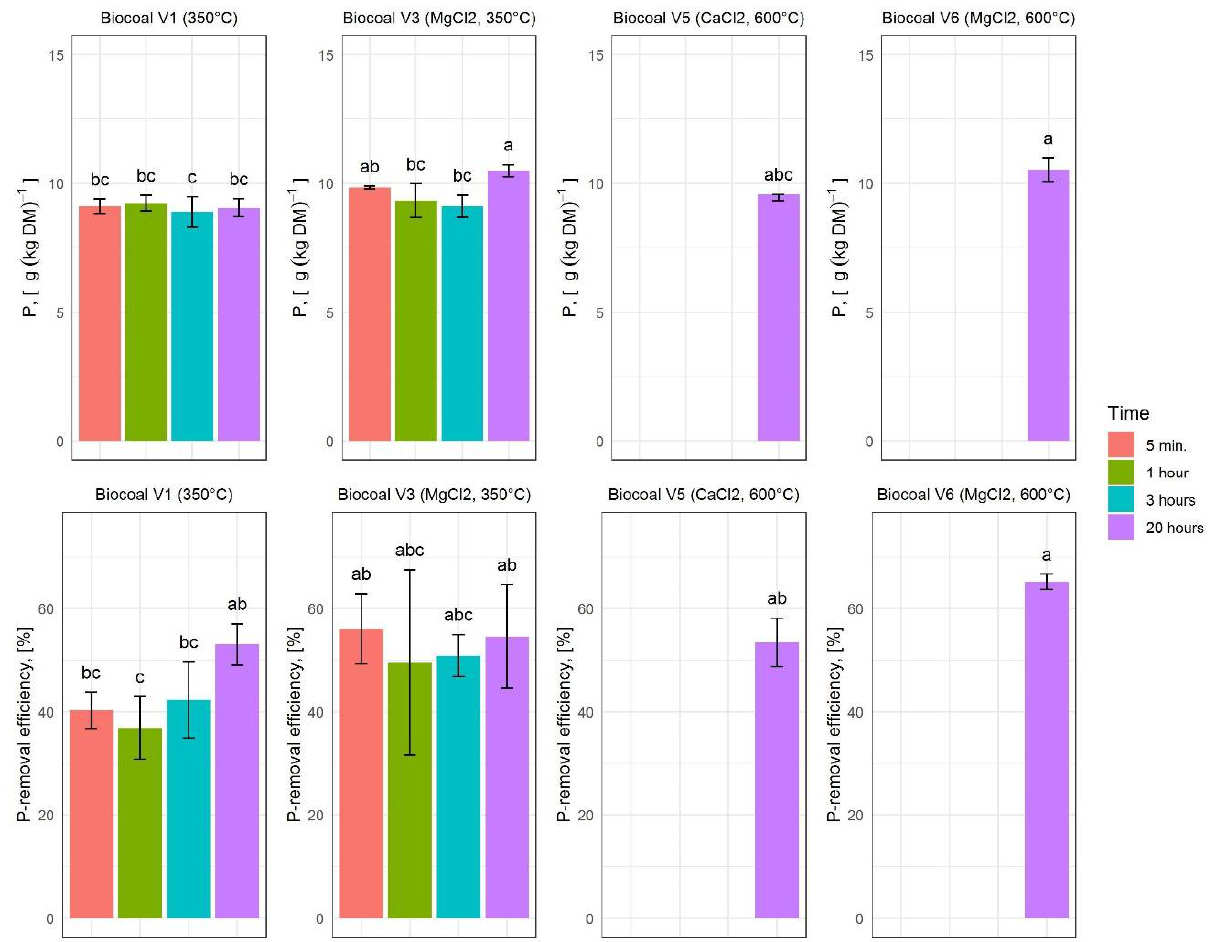
Figure 7. Phosphorus (P) concentration and P-removal efficiency for the different variants of added biocoal. The upper diagrams show the P concentration. The lower diagrams show the removal efficiency. Histograms are charted based on the mean values; error bars indicate the variability between the three replications. Lower case letters indicate significant differences according to Tukey test.